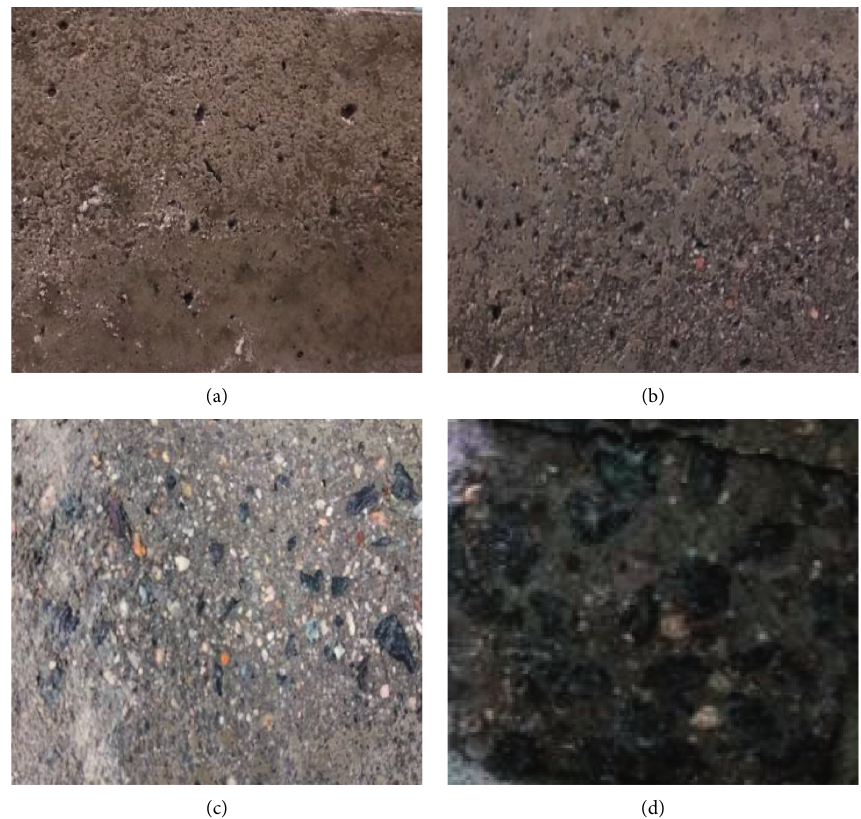
Figure 2: Concrete surface deterioration. (a) Pre freezing and thawing. (b) Mid freezing and thawing. (c) Late freeze-thaw. (d) Freeze-thaw damage.